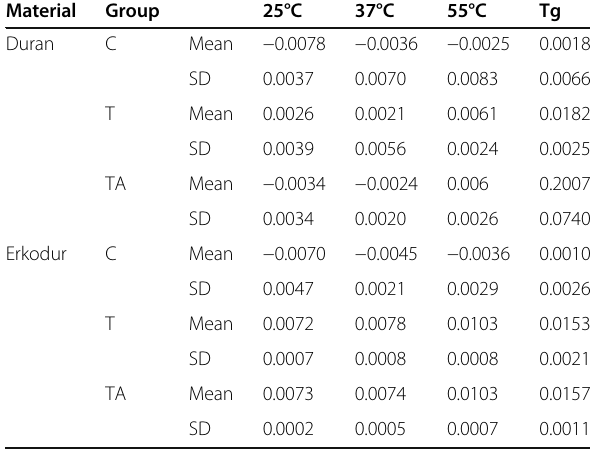
Table 7 Descriptive analysis of tan δ at different